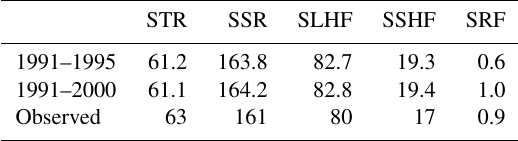
Table 1. Globally averaged surface energy fluxes for the CTRL sim- ulation. The values in the “Observed” row are the estimates from Trenberth et al. (2009) for the period from 2000 to 2004. STR rep- resents net surface thermal radiation, SSR represents net surface so- lar radiation, SLHF represents surface latent heat flux, SSHF rep- resents surface sensible heat flux, and SRF represents net surface energy. Units are in watts per square metre (Wm − 2 ) in all